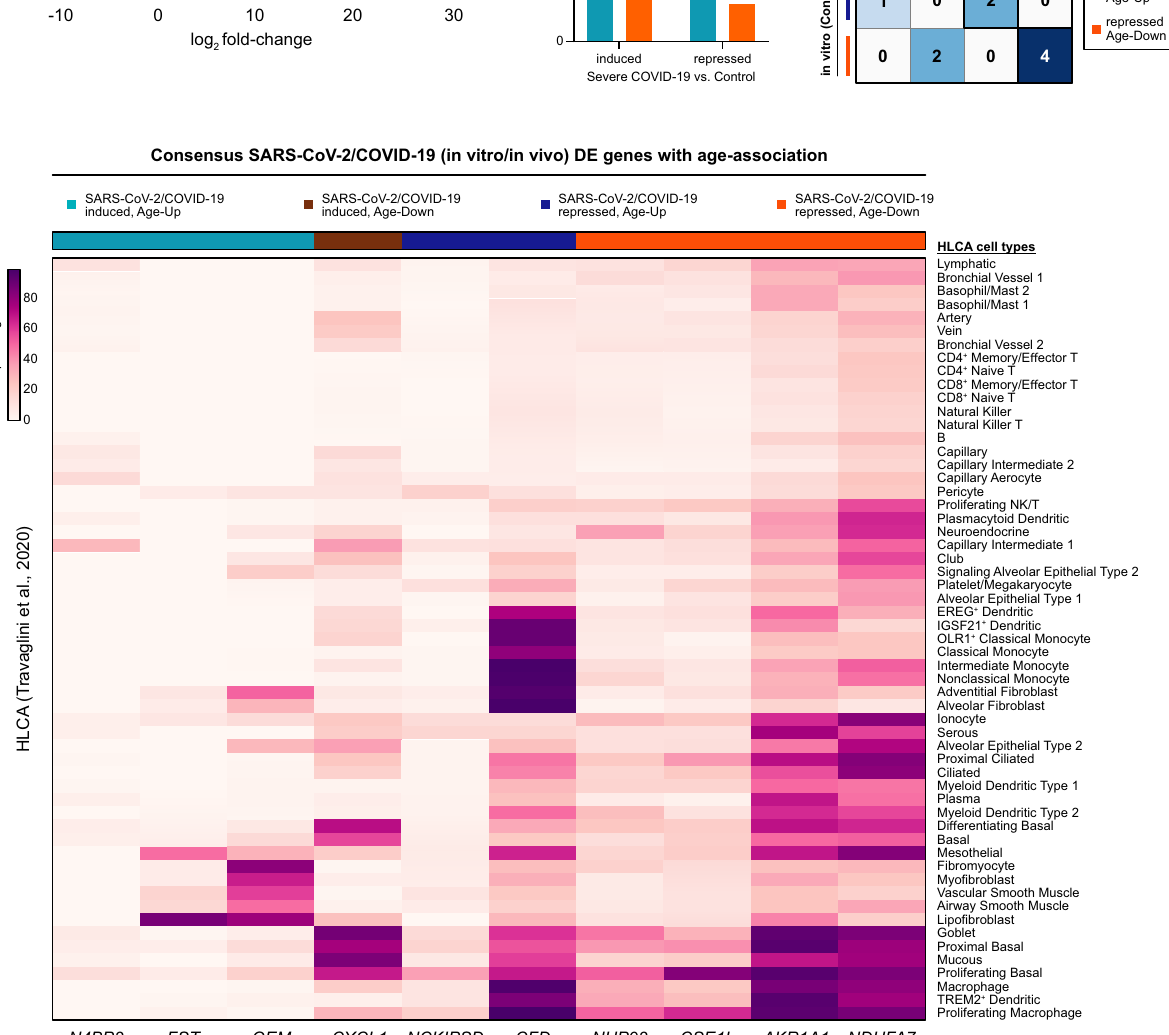
directionality of age-association (increase or decrease with